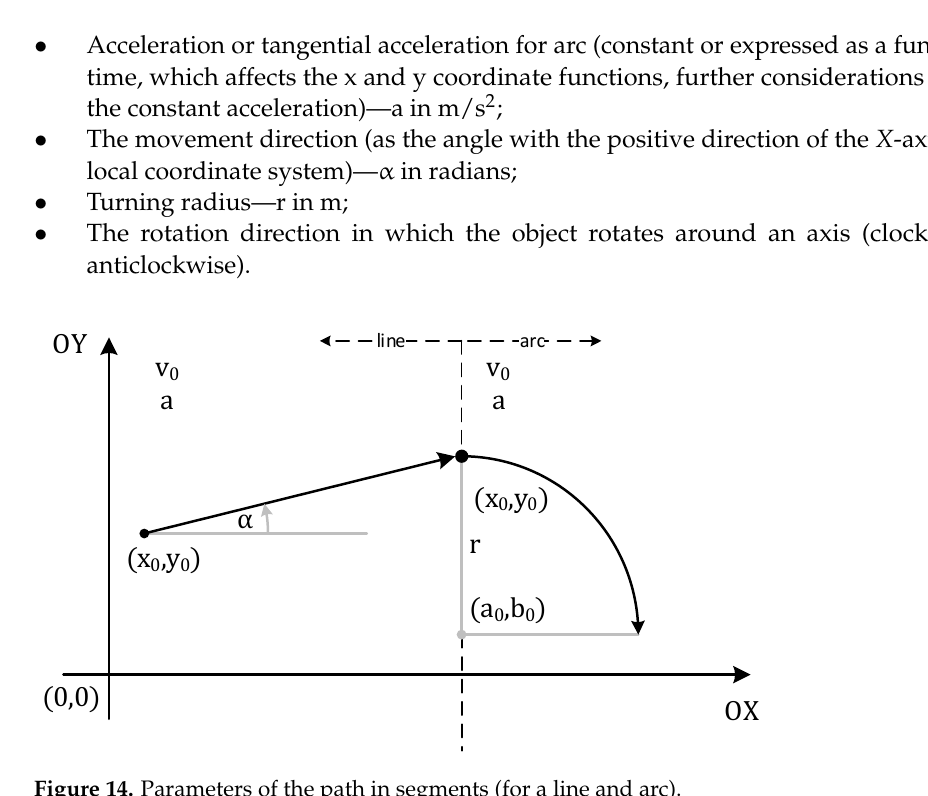
Figure 14. Parameters of the path in segments (for a line and arc).